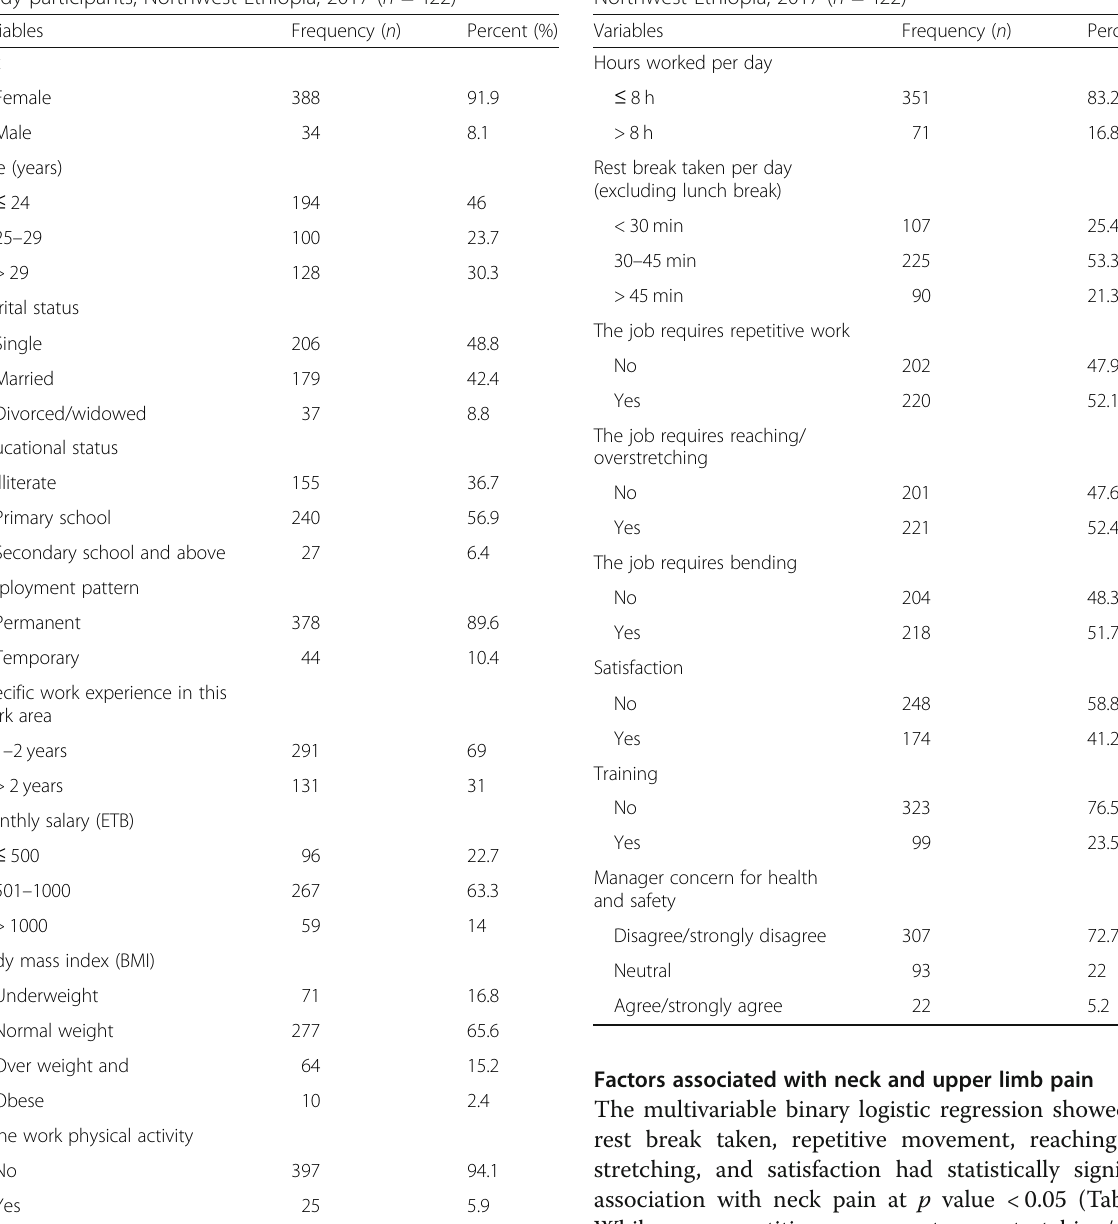
Table 2 Working conditions of the study